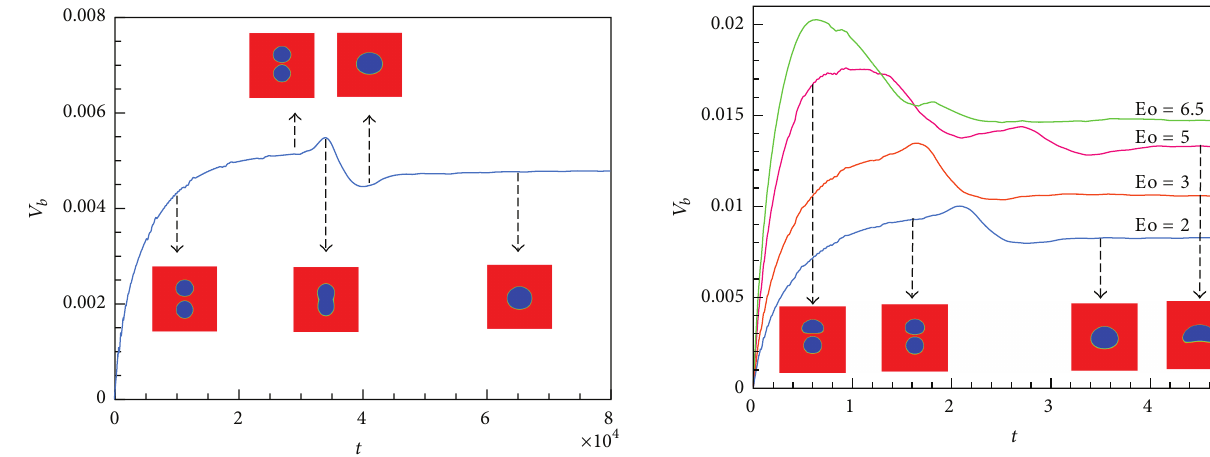
Figure 4: Time evolution of the rising velocity of two bubbles for different